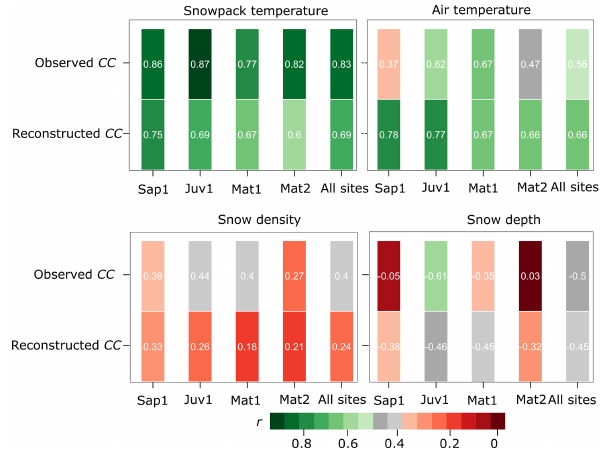
Figure 12. Inter-relationship between CC and snow density, snow depth, snowpack temperature, and air temperature. The colour bar represents the absolute value of the Pearson correlation coeffi- cient ( r